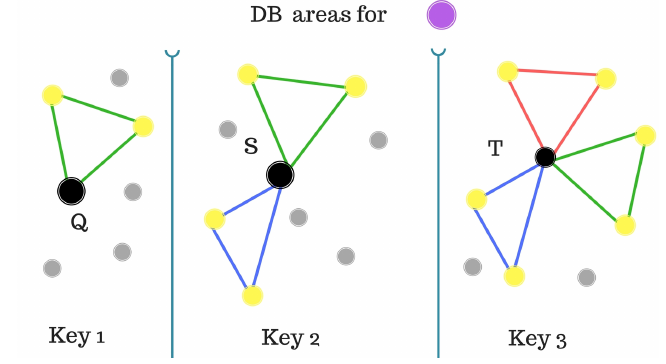
Figure 8. Database areas for stars